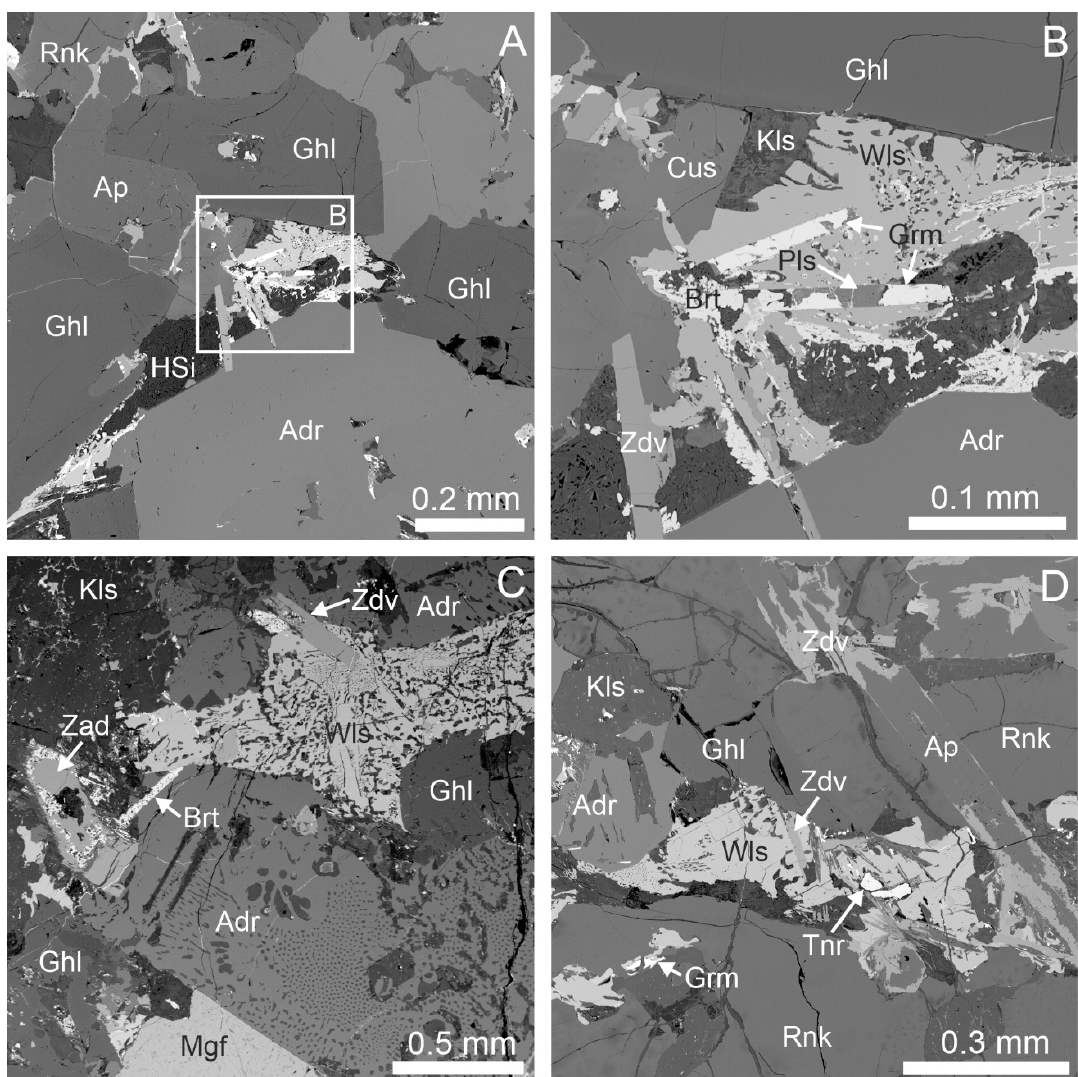
Figure 3. BSE (backscattered electrons) images of paralava with walstromite: ( A ) aggregate of Ba-minerals between large rock-forming minerals of paralava, Zuk Tamrur. Frame shows a fragment magnified in Figure 3B; ( B ) walstromite intergrowing with zadovite and gurimite is partially replaced by pliniusite. Kalsilite, in enclaves containing walstromite, is intensively substituted by a mixture of hydrosilicates and zeolites; ( C ) one of the biggest poikilitic grain of walstromite with kalsilite inclusions and Ti- andradite-flamite (partly altered) eutectoid intergrowth, Zuk Tamrur; ( D ) Euhedral zadovite crystals in walstromite, zadovite partially substituted for fluorapatite, Gurim Anticline. Adr: andradite, Ap: fluorapatite, Brt: baryte, Cus: cuspidine, Ghl: gehlenite, Grm: gurimite,